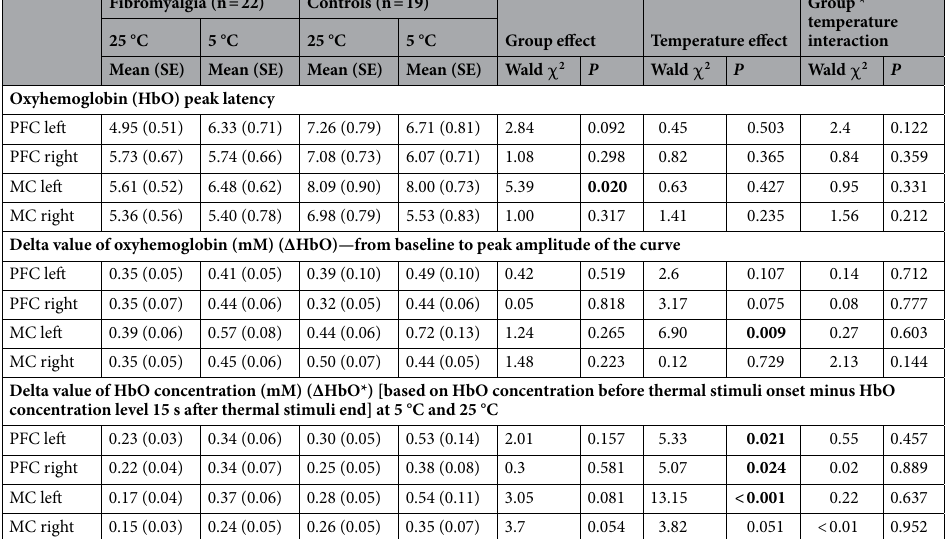
Table 2. Generalized Estimating Equations (GEEs) to compare the cortical activation parameters induced by thermal stimulus (25 °C and 5 °C) on the bilateral PFC and MC between fibromyalgia patients and controls (n = 41). Bold denotes data that actually had statistical difference and also the identification of each parameter - just in order to clarify data. Data are presented as mean and standard error (SE) (n = 41). SE standard error,